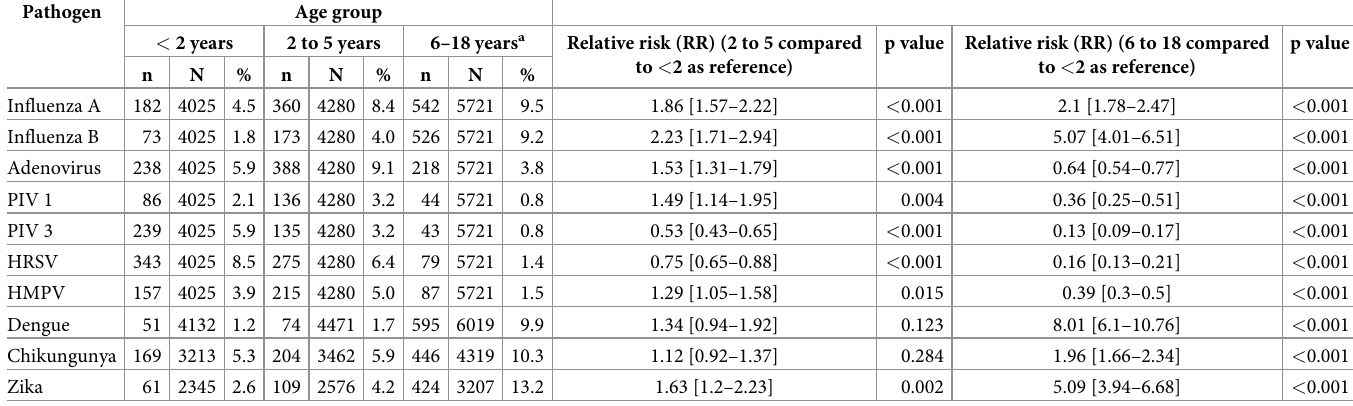
Table 2. Etiologic diagnosis by age group, Sentinel Enhanced Dengue Surveillance System (SEDSS), Southern Puerto Rico, 2012–2018.